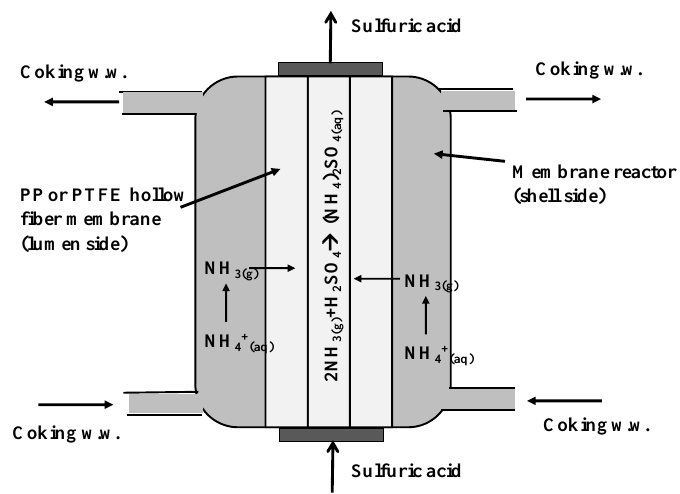
Figure 1. Principle of ammonia removal by hollow fiber membrane contactor (HFMC) module.